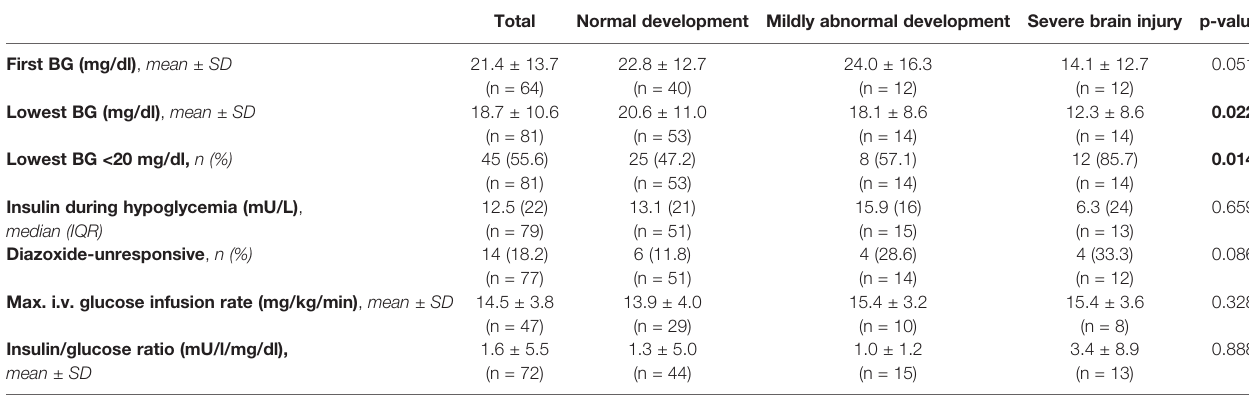
*Comparison of normal development vs. severe brain injury only. Bold type indicates signi fi cant result. n, number; SD, standard deviation; %, percent; IQR, interquartile range; BG, blood glucose; i.v., intravenous.